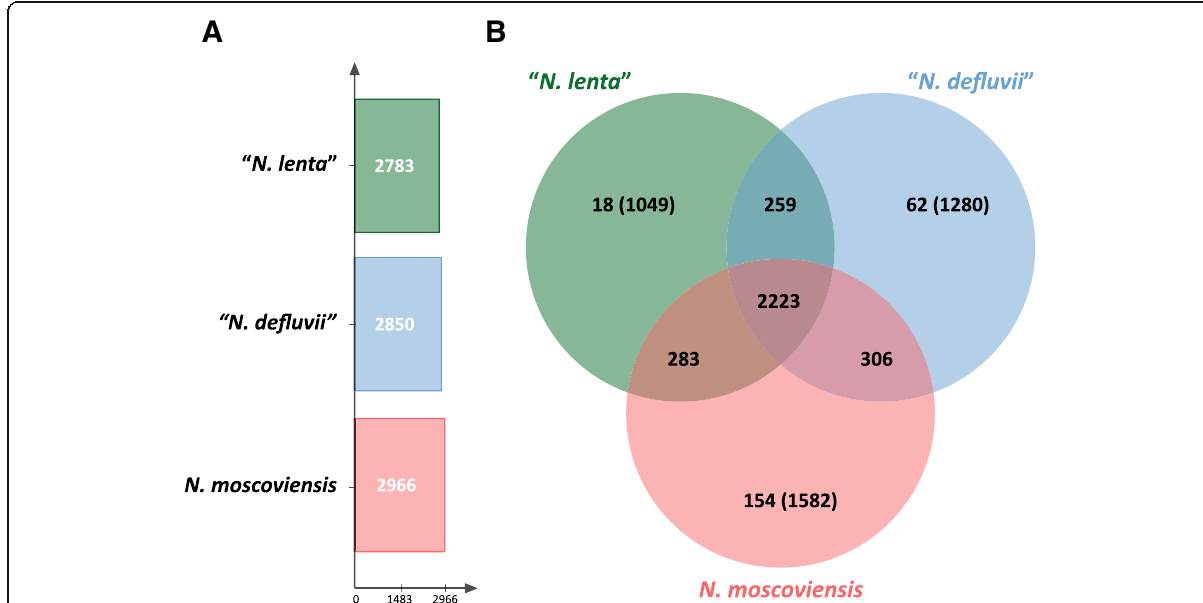
Fig. 4 Genome comparison of “ N. lenta ” with representatives of Nitrospira sublineages I and II. ( a ) Total number of inferred orthologous protein clusters for each species. ( b ) Venn diagram depicting the distribution of orthologous clusters among the genomes of “ N. lenta ” , “ N. defluvii ” and N. moscoviensis . The numbers indicate orthologous protein clusters; numbers in brackets depict the unique, unclustered proteins of each